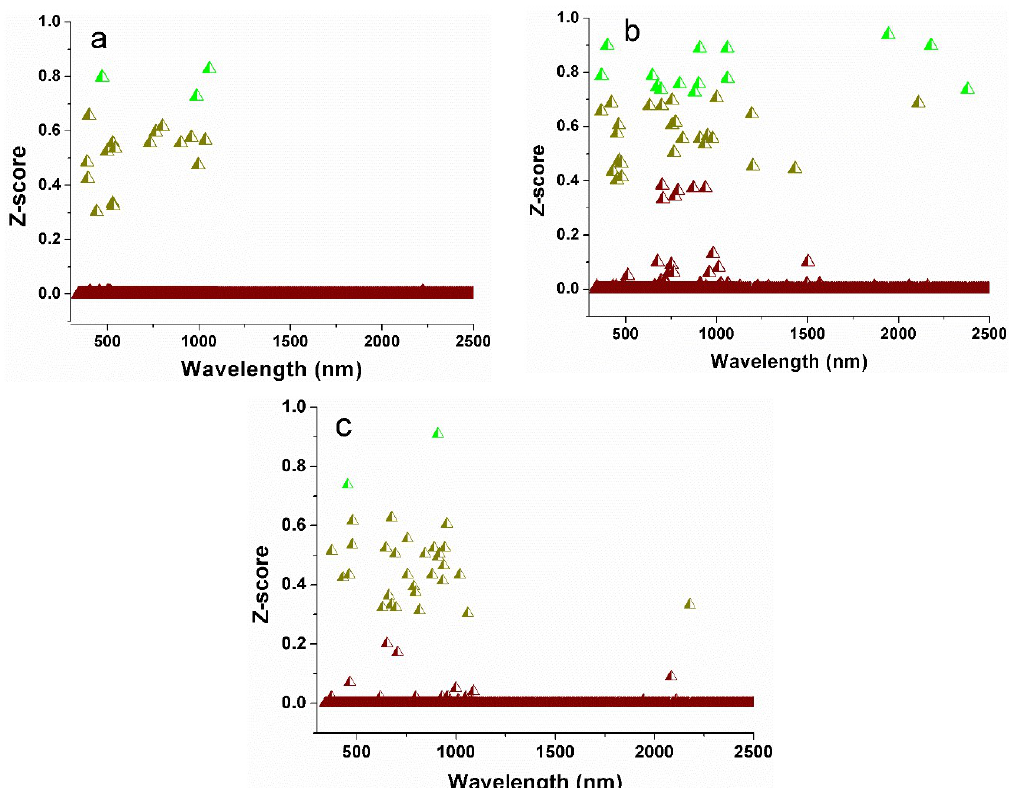
Figure 6. Z-scores showing the predictive capacity of individual first derivative spectral bands for three soil heavy metal contents obtained using the Boruta algorithm, where green, yellow, and purple symbols represent important, tentative, and unimportant spectral variables, respectively, for: ( a ) As; ( b ) Cd; and ( c ) Hg (p = 0.01).